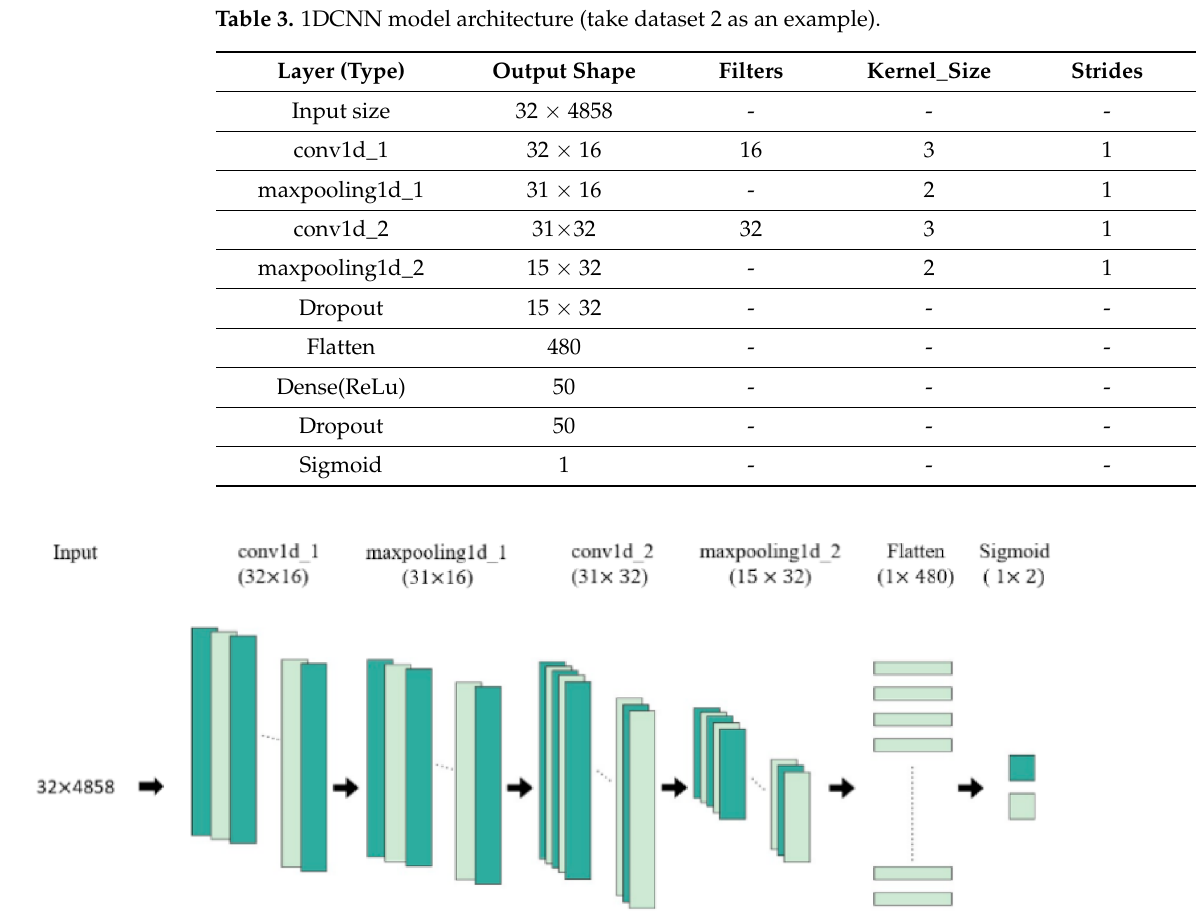
Figure 5. 1DCNN model architecture diagram (take dataset 2 as an